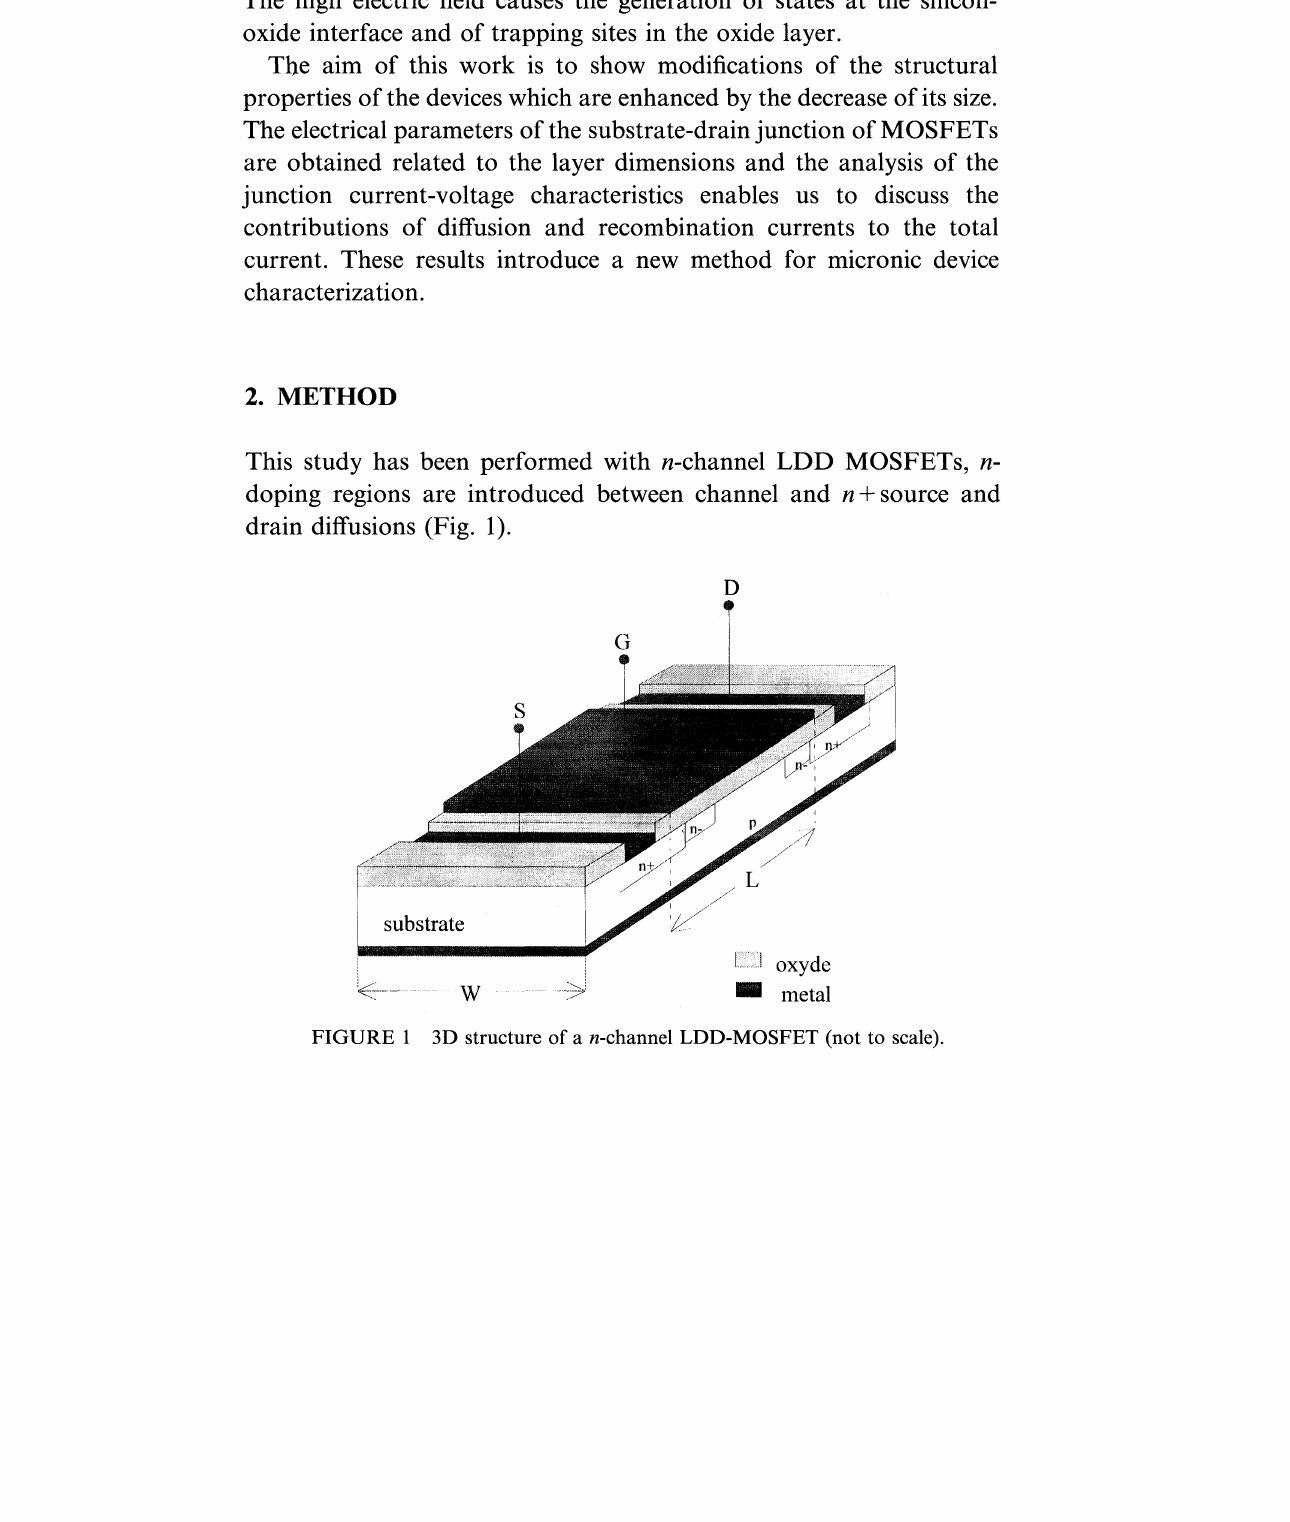
3D structure of a n-channel LDD-MOSFET (not to